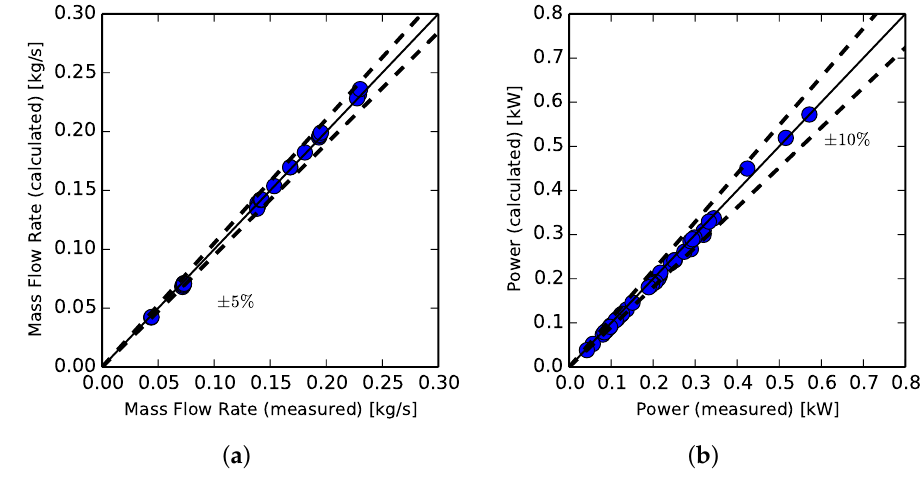
Figure 10. Validation of the refrigerant diaphragm pump (Wanner Eng. D03XABTHFEHA) with R134a. Dashed lines show the maximum relative erros of all the 42 steady-state points. ( a ) Mass flow rate mean absolute percentage error (MAPE) = 1.85%; ( b ) Input power MAPE =